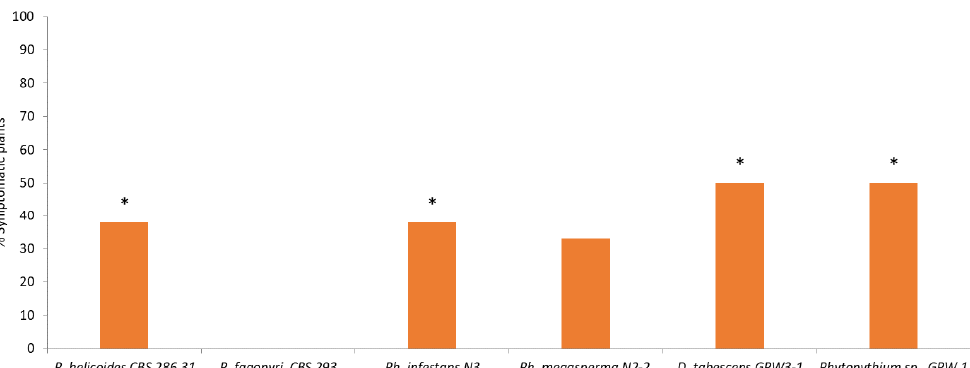
Figure 5. Percentage of symptomatic kiwifruit plants ( n = 8) in greenhouse experiment after inoculation with 4 different pathogenic fungi isolated form commercial orchards. Phytopythium CBS 286.31 and Phytopythium fagopyri CBS 293 were included as reference strains. Asterisk indicate significant differences between control and inoculated plants according to Marascuilo procedure ( χ 2 = 0.05).